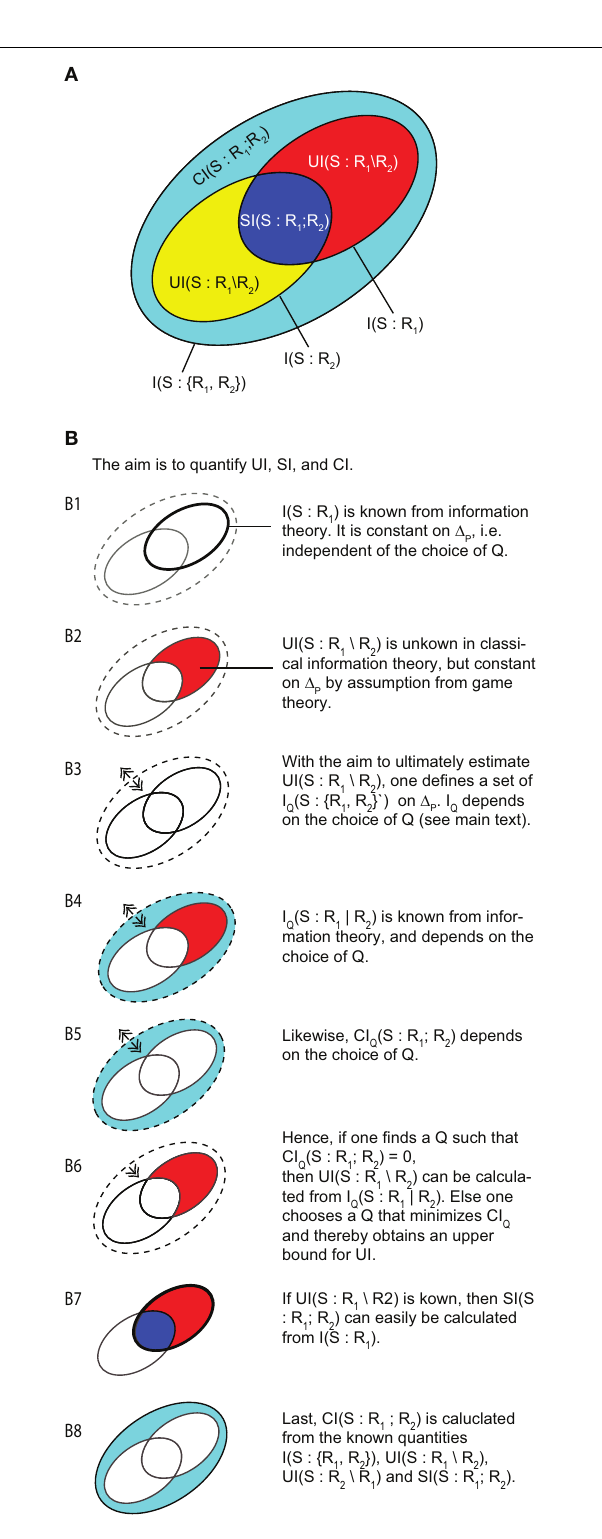
FIGURE 3 | (A) Overview of the contributions to a partial information decompositions of the mutual information I(S:R1;R2). (B) (1–8) Schematic derivation of the definition of unique information by Bertschinger et al. (2014).This figure is meant as a guide to the structure of the original work that should be consulted for the rigorous treatment of the